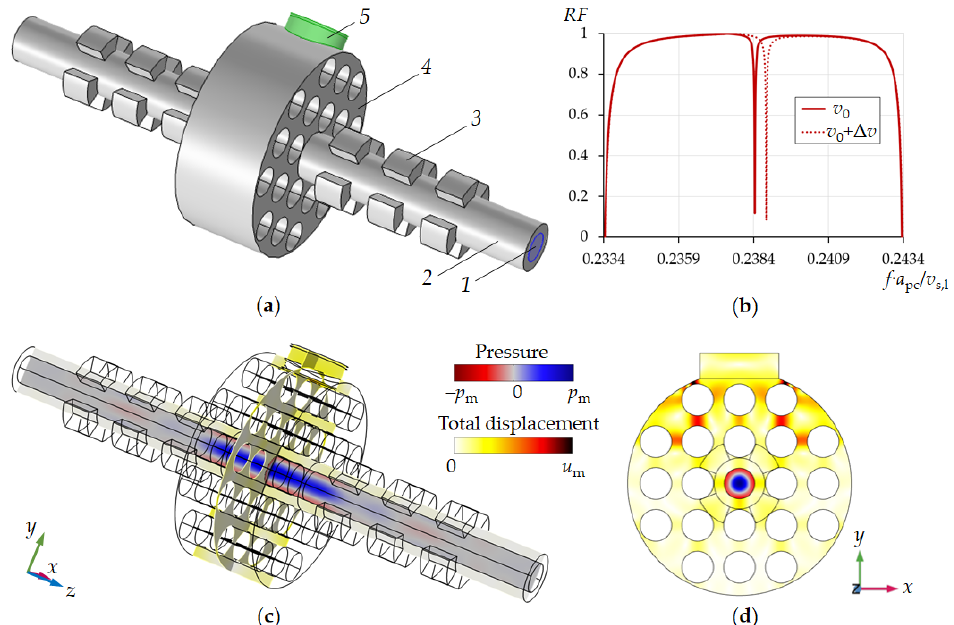
Figure 7. Design of the phononic crystal sensor, simulation results at resonance conditions in the pipe ( a ) with 1—liquid, 2—pipe, 3—sectioned rings, 4—2D phononic crystal, 5—piezoelectric transducer. Reflection spectra of sensor ( b ). Pressure and displacement field distributions close to liquid resonance conditions ( c , d ).